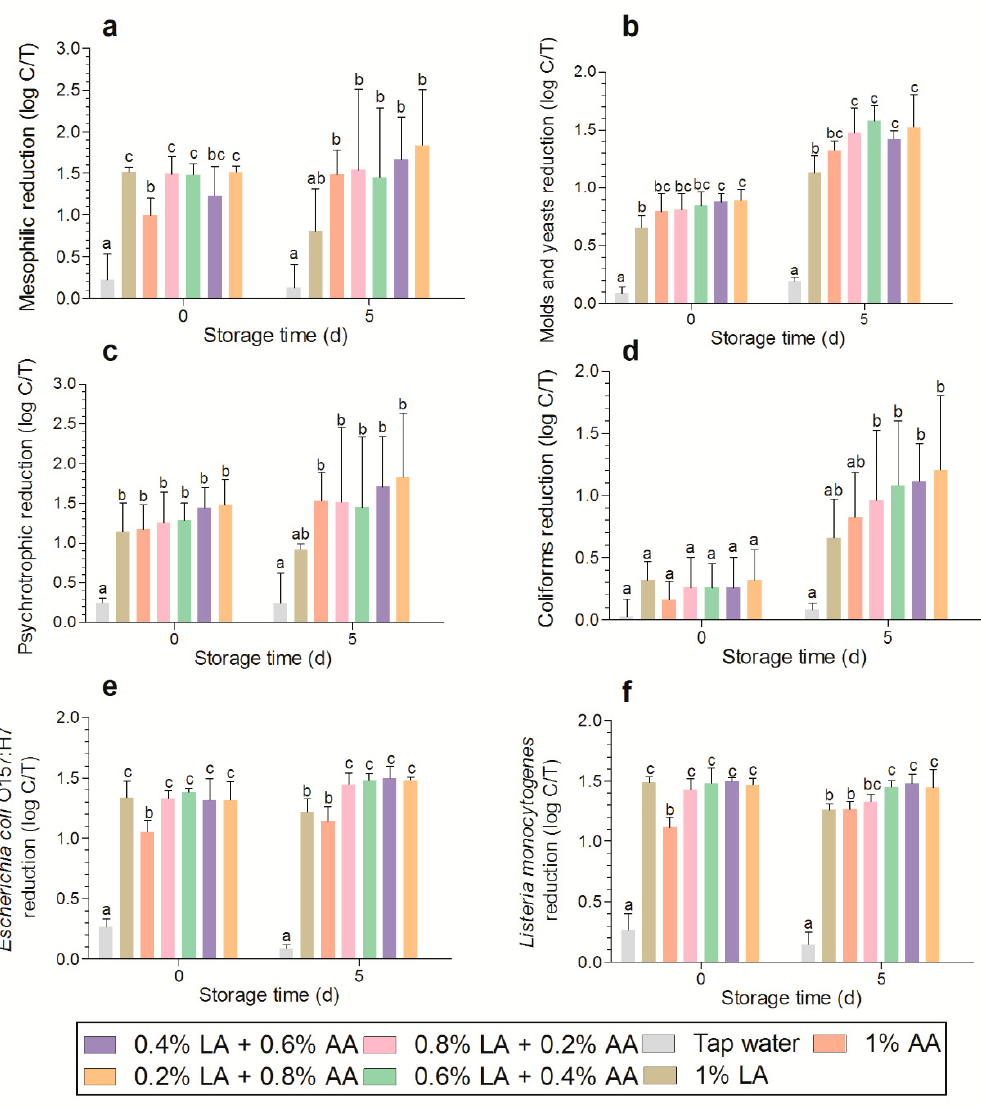
Figure 2. Microbial reduction of aerobic mesophilic counts ( a ), molds and yeasts ( b ), aerobic psychrotrophic counts ( c ), coliforms ( d ), inoculated E. coli O157:H7 ( e ), and inoculated L. monocytogenes ( f ) present on lettuce. Data represent the means ± standard deviation, and the different letters above the columns indicate significant differences ( p < 0.05). LA, lactic acid; AA, acetic acid. Log C/T indicates the difference in microbial counts between the control and treatment groups at the same time points.